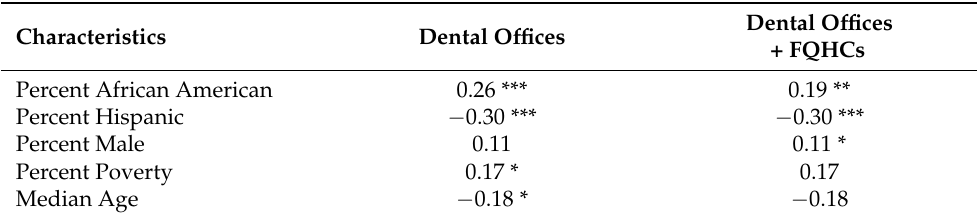
Table 2. Correlation coefficients between Tract-Level Demographic Characteristics and Distance to Nearest Dental Office ( n = 179 census tracts).